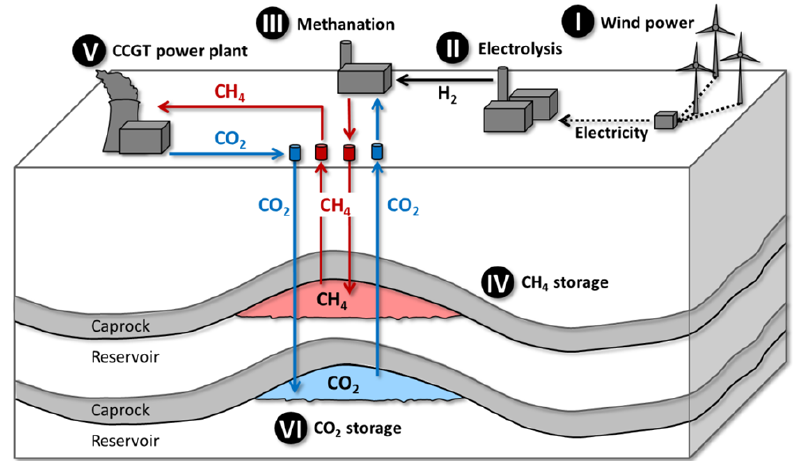
Figure 1. Schematic of the PGP cycle integrated with geological storage to decarbonise the conventional P2G